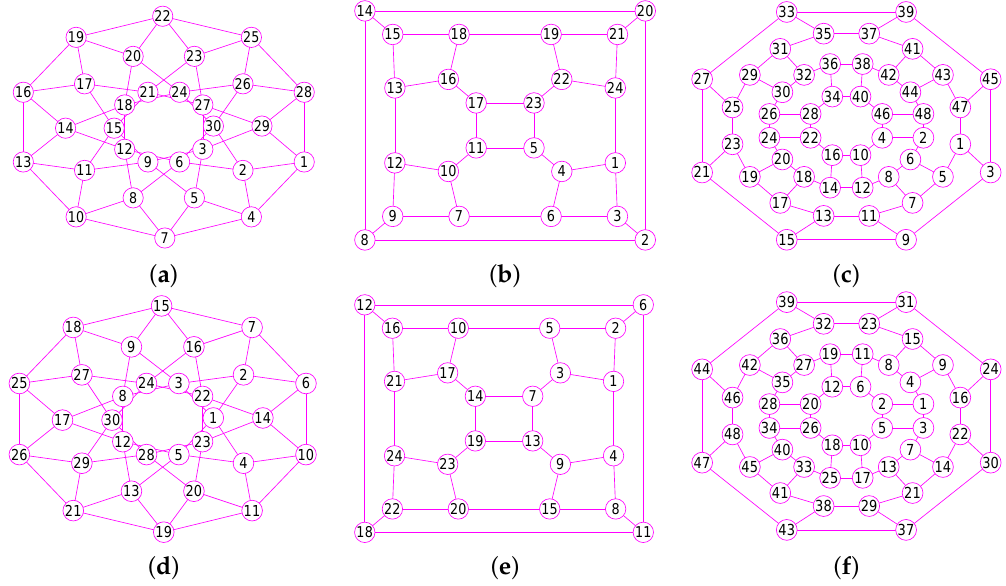
Figure 16. The TopMost graphs of three graphs G 19 , G 20 and G 21 . ( a ) The Icosidodecahedral Graph G 19 with 30 nodes and 60 edges; ( b ) The truncated octahedron graph G 20 with 24 nodes and 36 edges; ( c ) The great rhombicuboctahedron graph G 21 of 48 nodes and 72 edges; ( d ) The TopMost graph of G 19 ; ( e ) The TopMost graph of G 20 ; ( f ) The TopMost graph of G 21